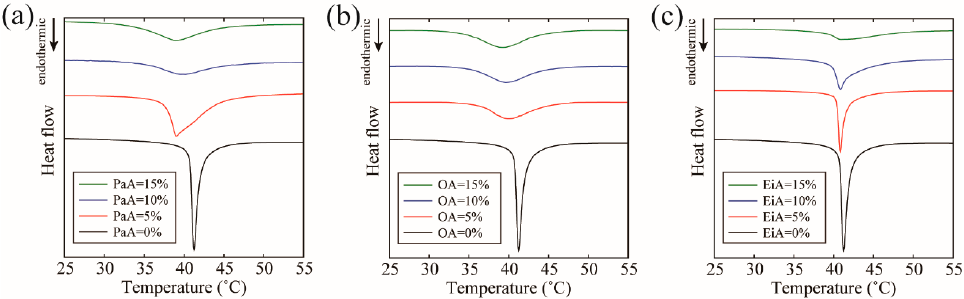
Figure 4. DSC thermographs for ( a ) DPPC/PaA/Chol, ( b ) DPPC/OA/Chol, and ( c ) DPPC/EiA/Chol. The black, red, blue, and green lines indicate DPPC/MUFA/Chol ratios of 90/0/10, 85/5/10, 80/10/10, and 75/15/10, respectively.